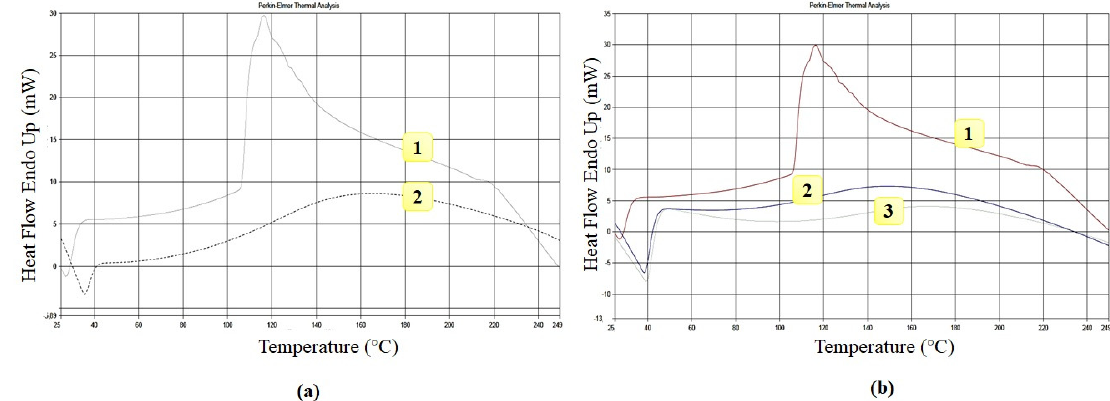
Figure 7. Differential scanning calorimetry (DSC): ( a ) First heating scan (curve 1) and second heating scan (curve 2) of uncured acrylic resin mixture (DS); ( b ) first heating scans of acrylic resins mixture (curve 1), DS/KEFL (curve 3) and DS/23BA/KEFL (curve 2).